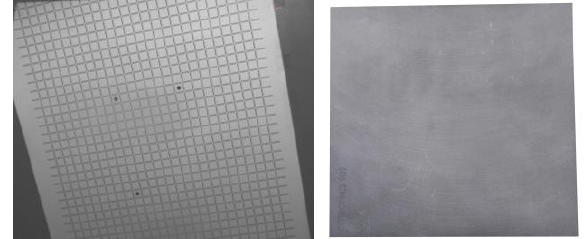
Figure 8. Grid pattern (left) and ceramic plane (right)